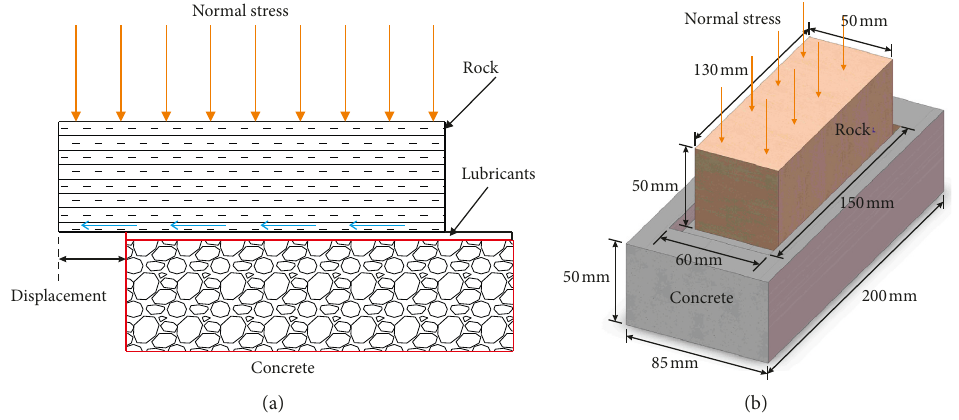
Figure 5: Interface friction testing in direct shear.